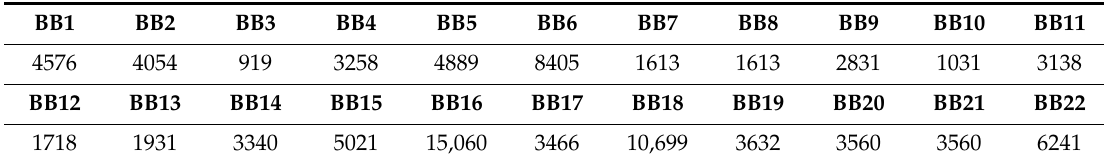
Table 1. Square meters of heated area for each BB.